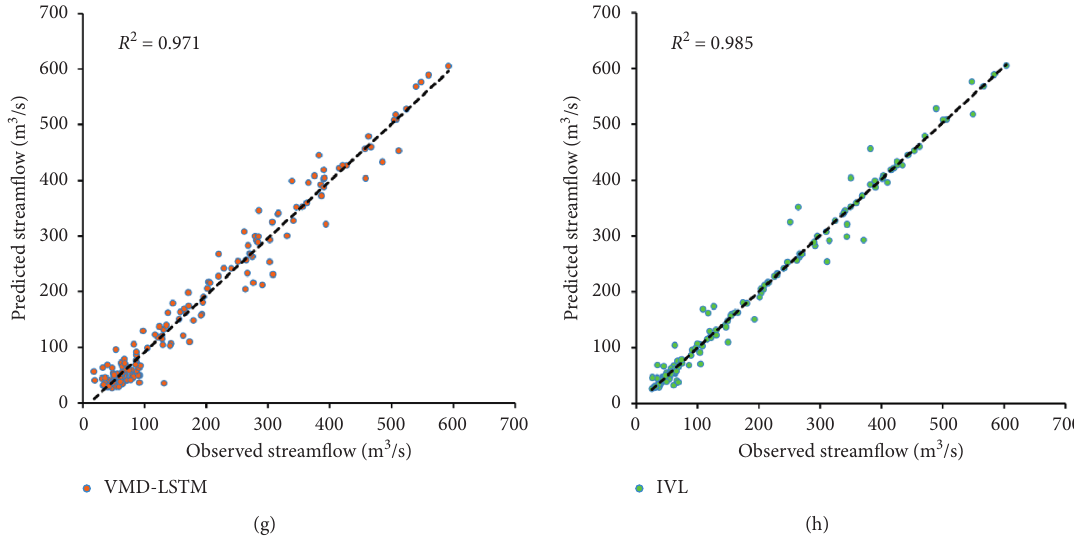
Figure 12: Scatterplot of observed and predicted streamflow using RBF, SVR, RFR, GRU, LSTM, ICEEMDAN-LSTM, VMD-LSTM, and IVL models for the testing period.